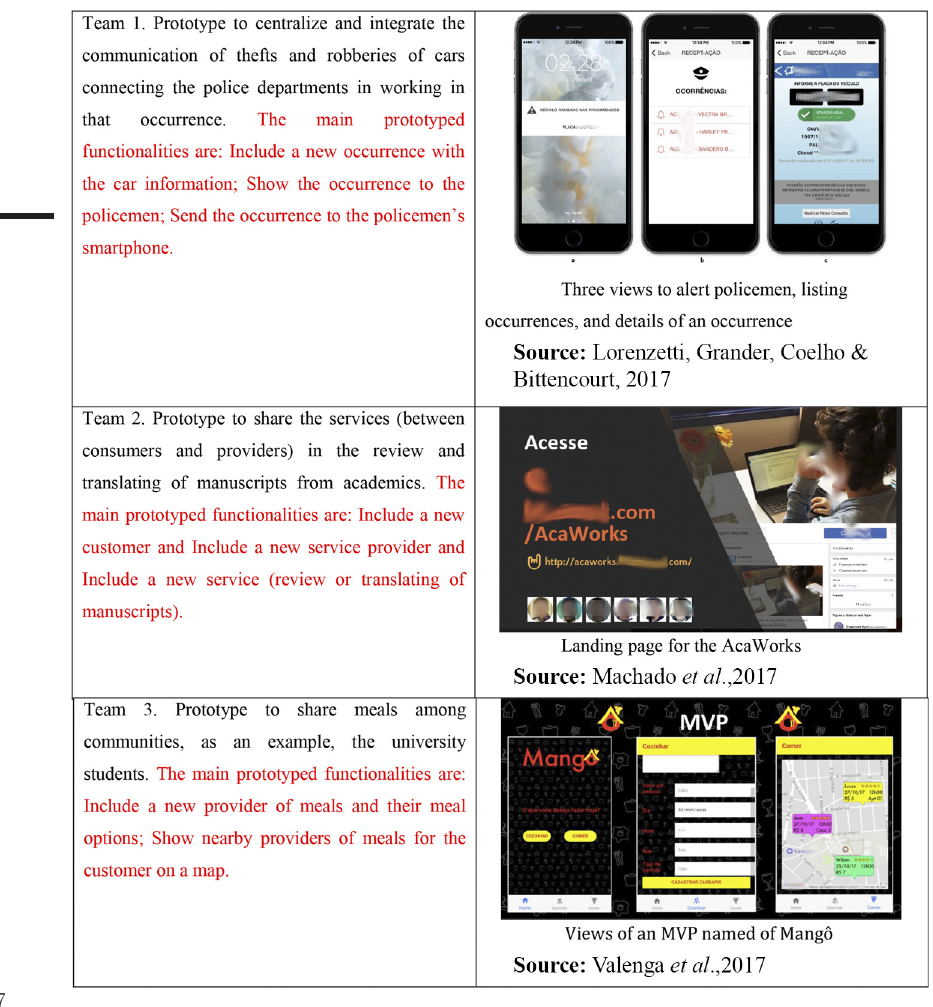
Figure 2. Prototypes-2017